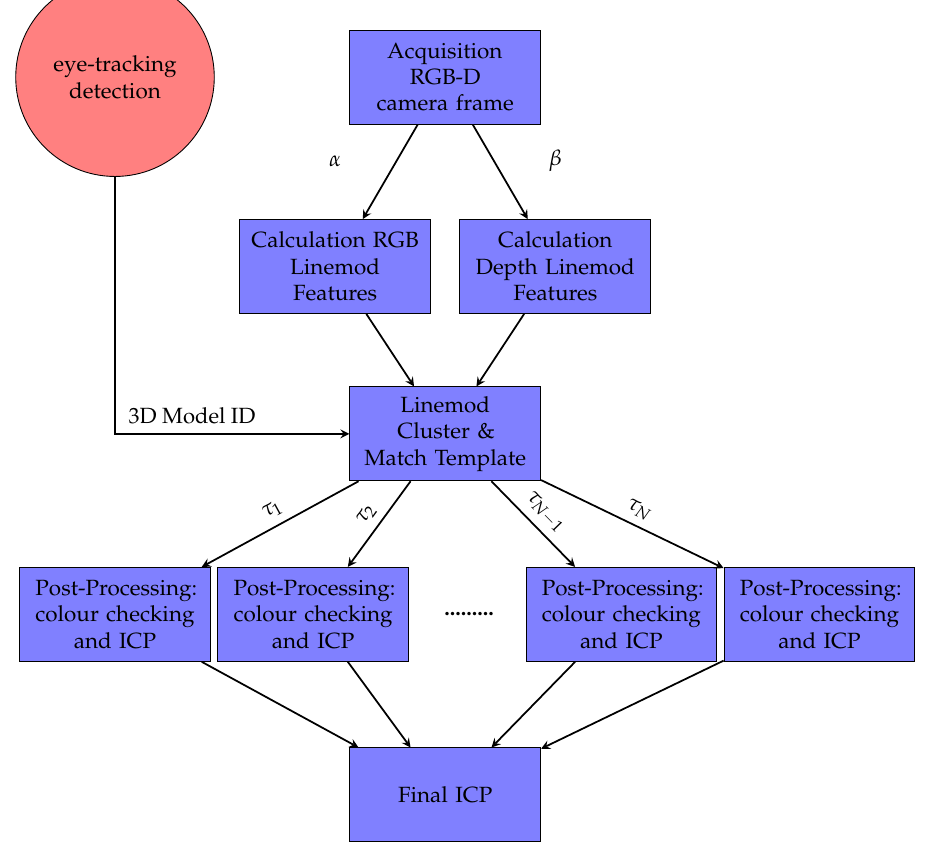
Figure 4. Flow diagram of the LINEMOD++ implemented algorithm. α and β are two independent processes, and τ represents a thread. ICP: iterative closest point.